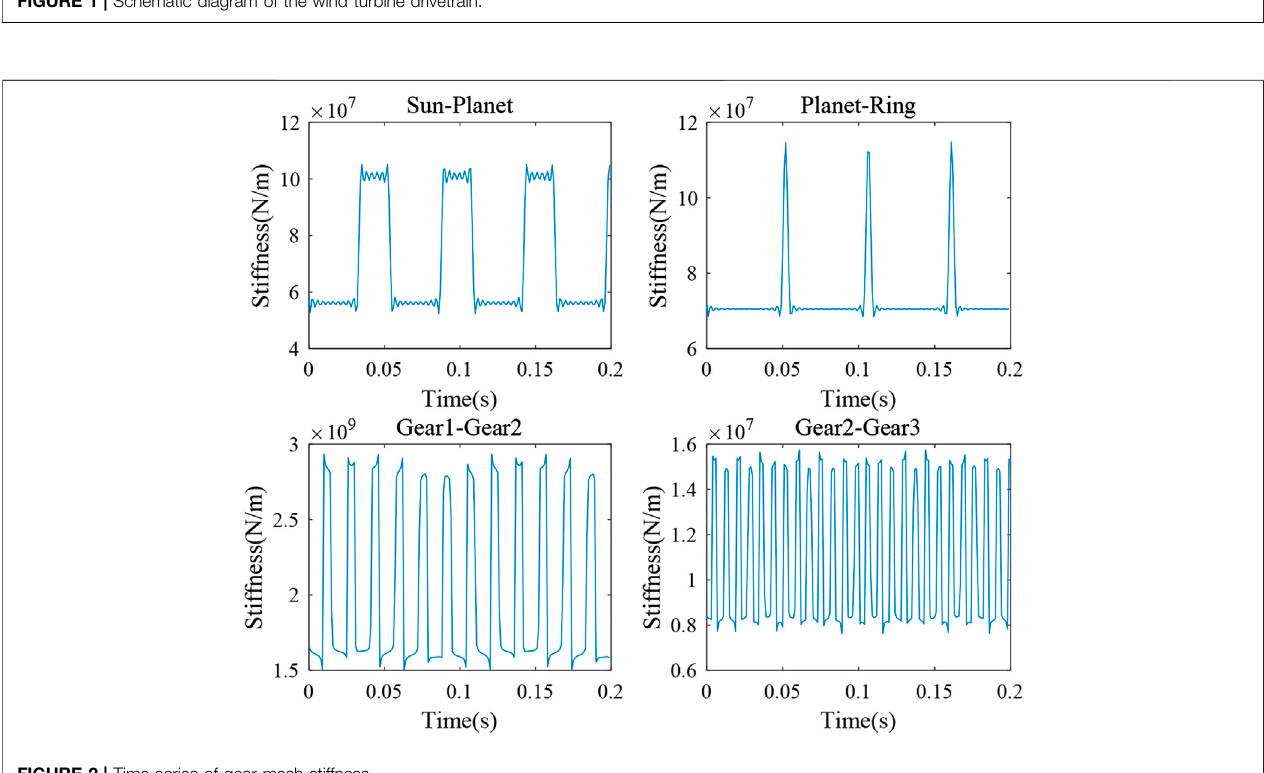
FIGURE 2 | Time series of gear mesh